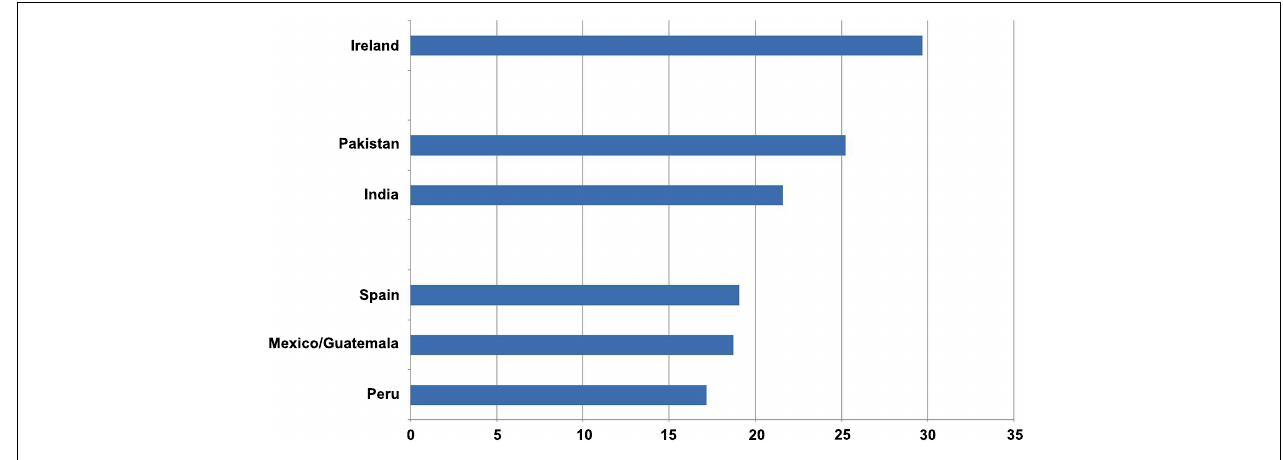
FIGURE 1 | TMDbrief scores by